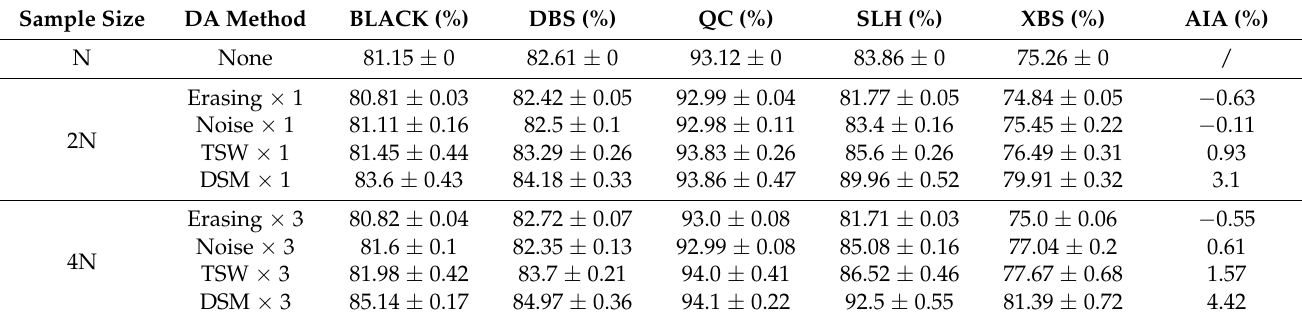
Table 3. Results of SVM training using G1 and G2